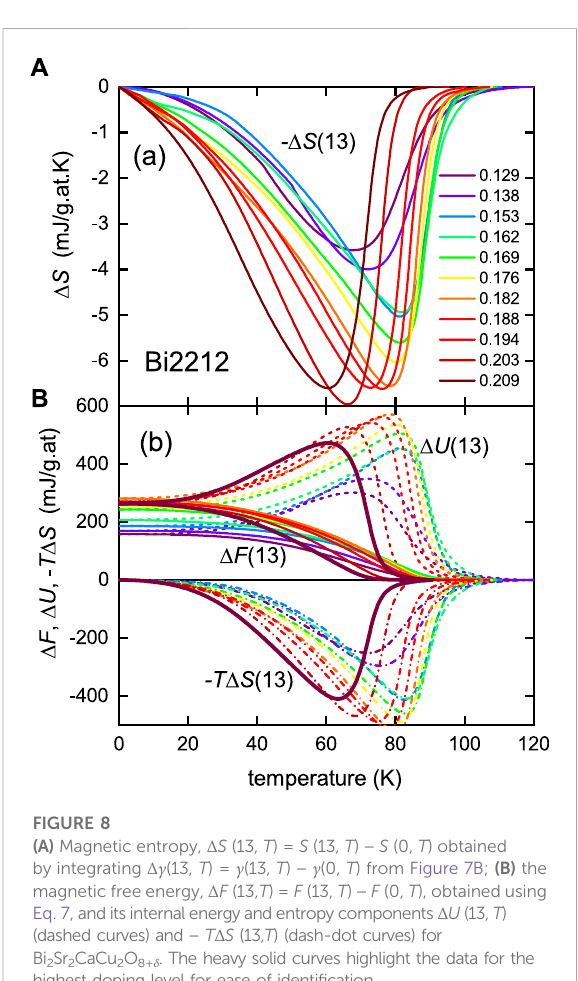
FIGURE 8 (A) Magnetic entropy, Δ S (13, T ) = S (13, T ) − S (0, T ) obtained by integrating Δ γ (13, T ) = γ (13, T ) − γ (0, T ) from Figure 7B; (B) the magnetic free energy, Δ F (13, T ) = F (13, T ) − F (0, T ), obtained using Eq. 7, anditsinternalenergyandentropycomponents Δ U (13, T ) (dashed curves) and − T Δ S (13, T ) (dash-dot curves) for Bi 2 Sr 2 CaCu 2 O 8+ δ . The heavy solid curves highlight the data for the highest doping level for ease of identi fi cation.